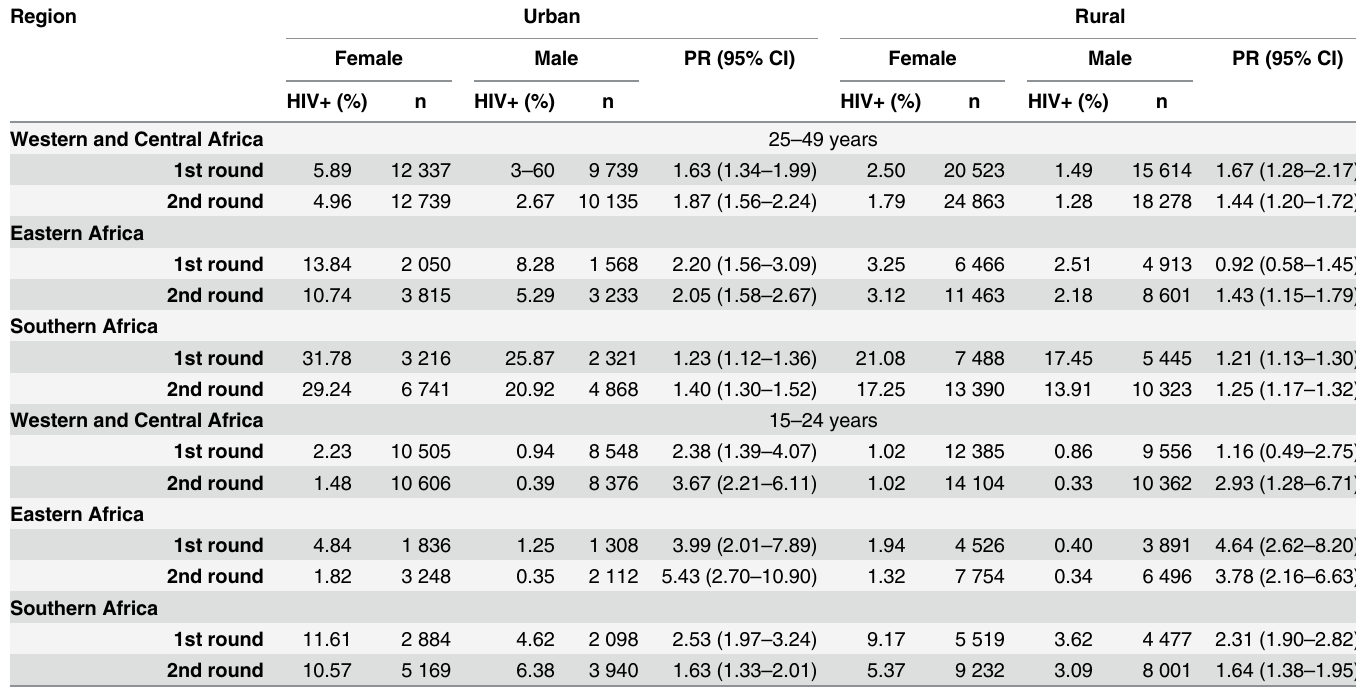
Table 3. Age-adjusted female: male HIV prevalence ratio by region and urban/rural residence.